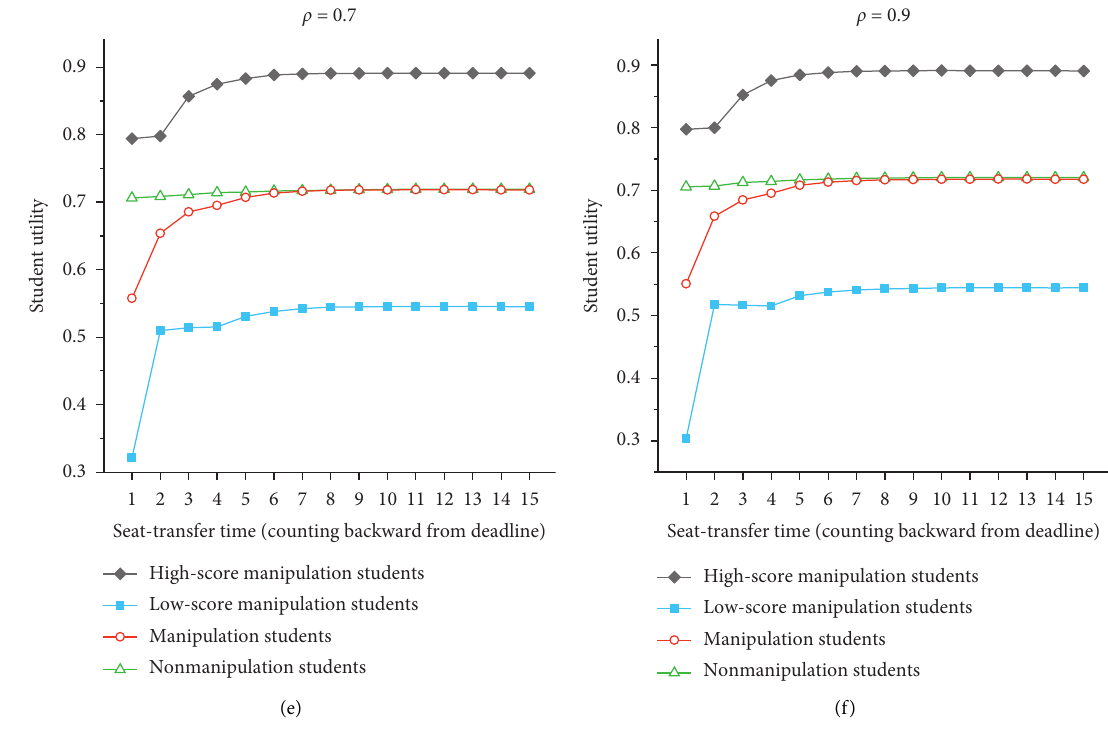
Figure 1: Utilities of manipulation and nonmanipulation students under different manipulation-seeking student ratio ρ . The x -axis represents the time when the high-score manipulation student transfers the seat to the low-score manipulation student, and it is the round number counted backward from the deadline. The y -axis represents the average utilities of students. The black line marked with diamonds is the average utility of the high-score manipulation students, the blue line marked with squares is for low-score manipulation students, the red line with circles is the average utility of all the manipulation students (both high- and low-score manipulation students), and the green line with triangle is for nonmanipulation students. The solid marks represent the optimal transfer time t ∗ seat-transfer of manipulation students . For each parameter setting, we run the simulation for 100 times and calculate the average utilities.